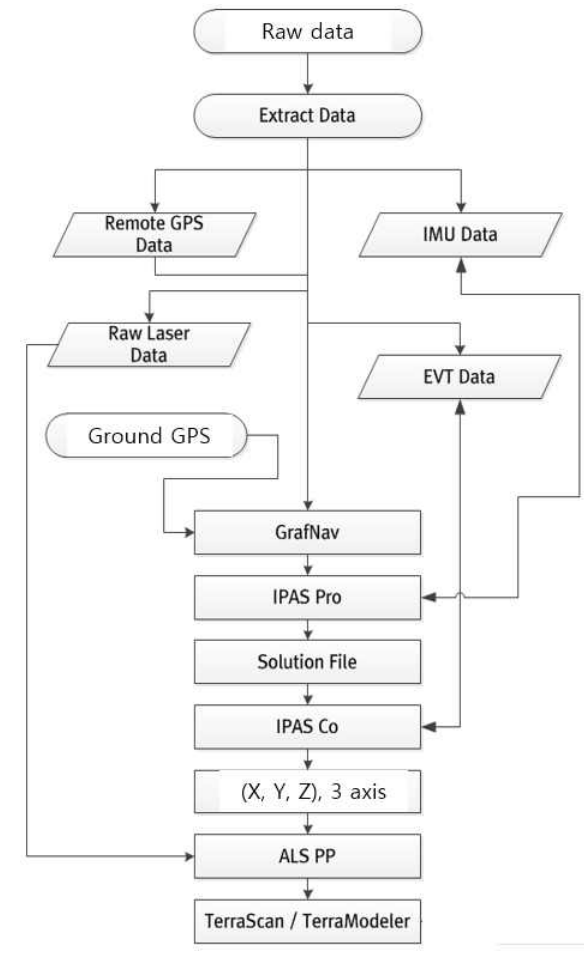
Figure 3. Flowchart for SW application